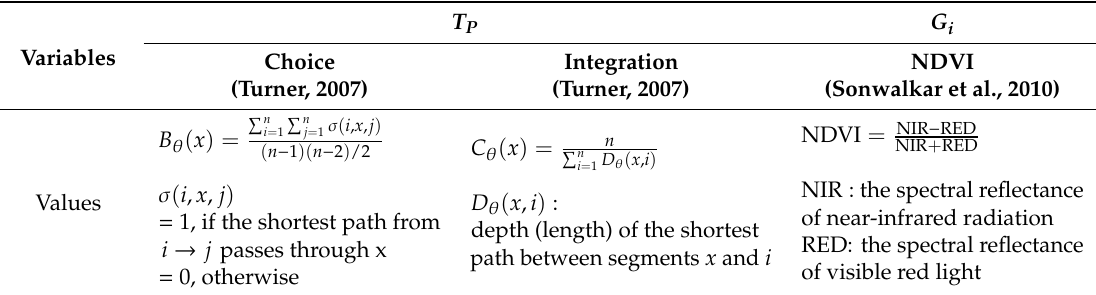
Table 1. Description of values used for Topology and Greenness variables of the urban green accessibility (UGA) index. NDVI: normalized di ff erence vegetation